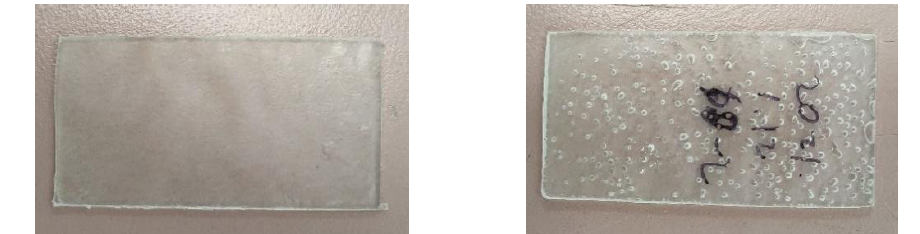
Figure 14. MLR experimentation samples. Left: control (0 kGy)-no visible pores; Right: 56 kGy gamma dose pre-irradiated – showing visible pores.